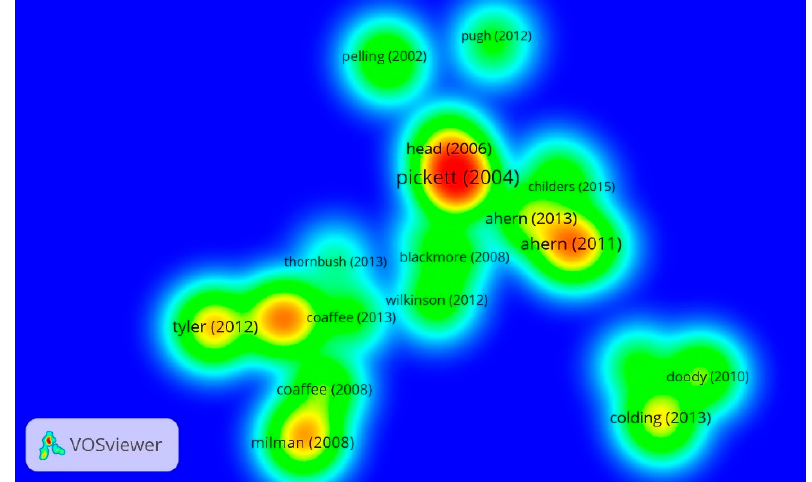
Figure 5. Citation map representing influential studies (resilience).